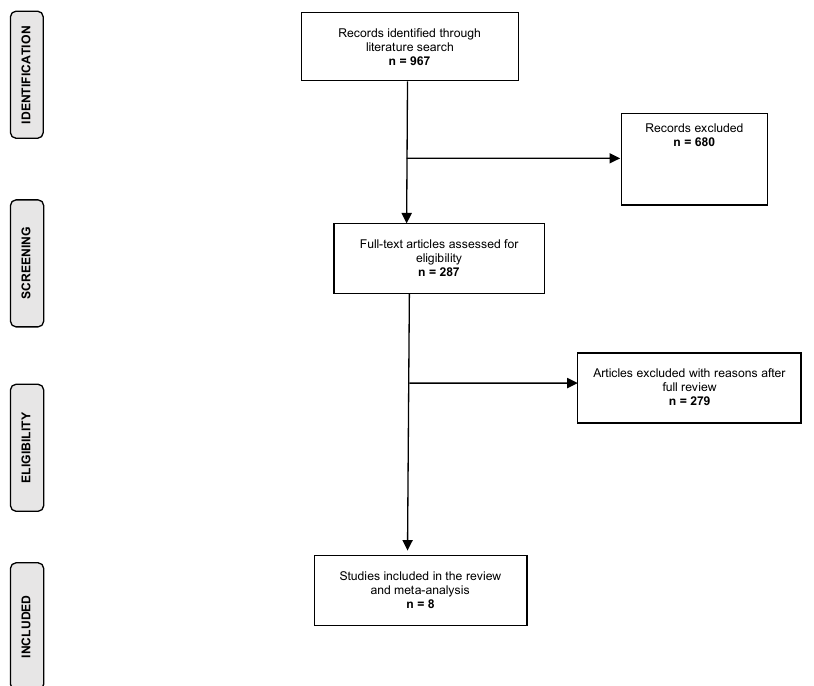
Figure 1. Flow chart of the literature search